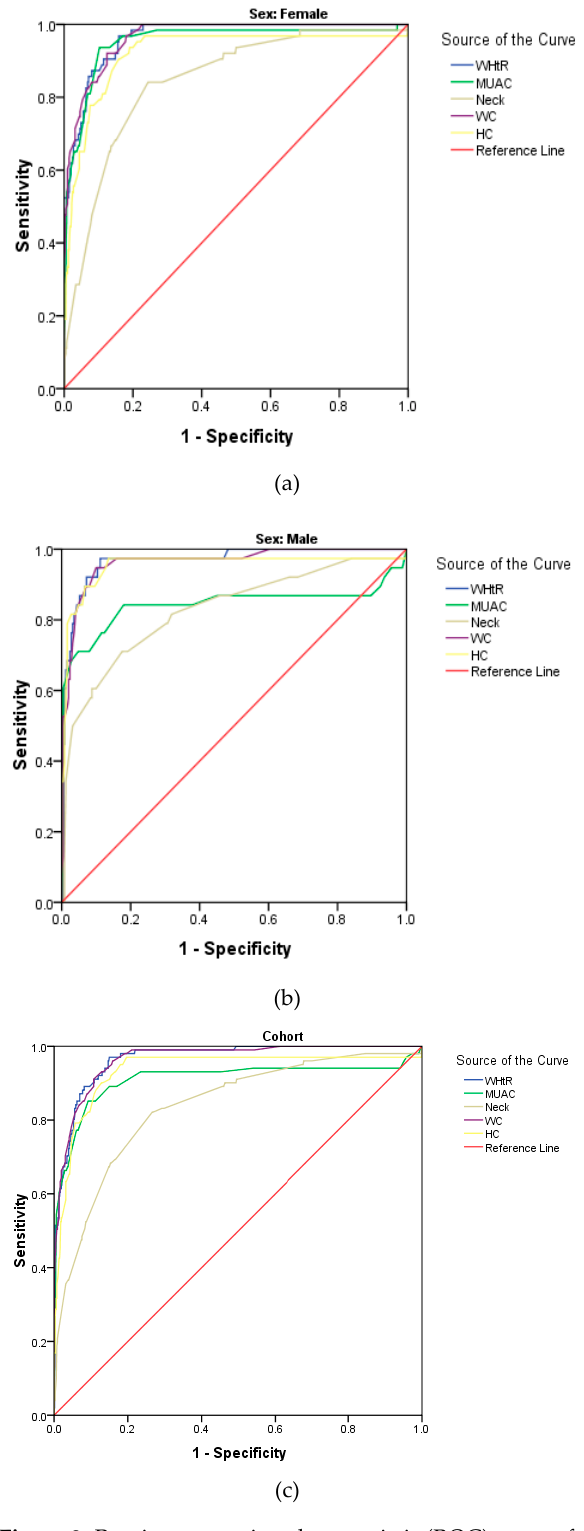
Figure 2. Receiver operating characteristic (ROC) curves for anthropometric measures using pBMI as reference in the cohort, females and males ( a – c ). Using pBMI as reference, the optimal cut-offs for obesity for WHtR, NC, MUAC, WC and HC in the cohort were 0.481, 30.95 cm, 27.95 cm, 76.1 cm and 95.75 cm, respectively.